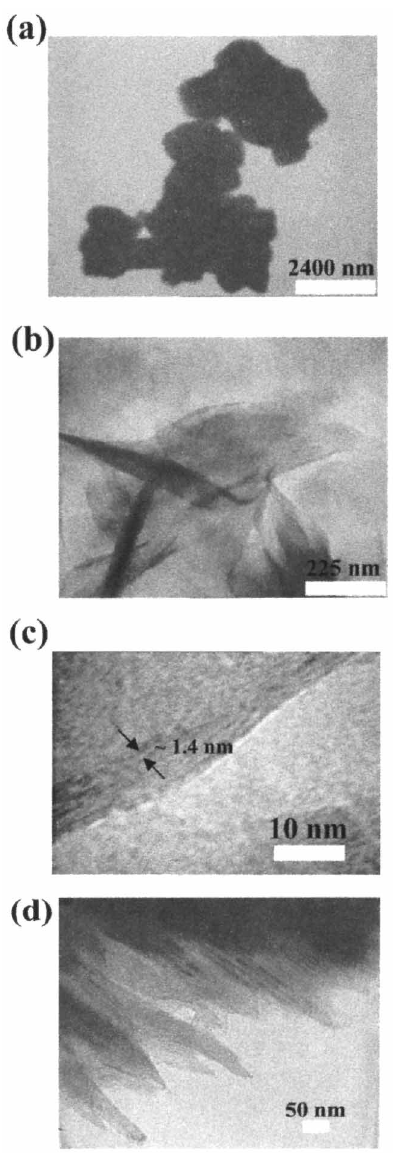
FIGURE 6 Transmission electron micrographs for (a) pristine V 2 O 5 , (b) and (c) VP1, and (d)